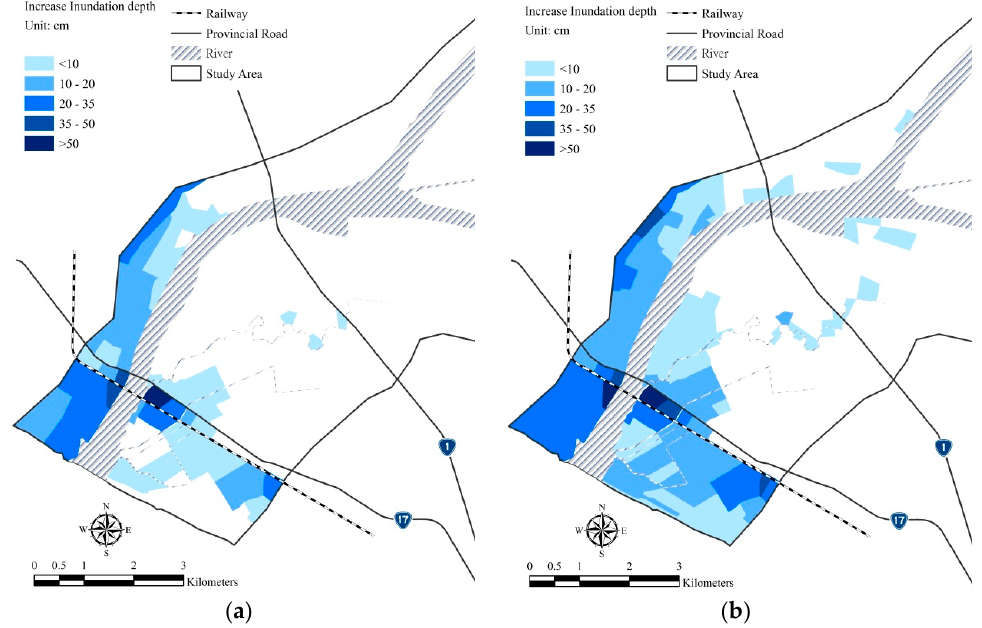
Figure 9. ( a ) Spatial distribution of inundation depth increase after land subsidence for a two-day storm under a 5-year return period; ( b ) Spatial distribution of inundation depth increase after land subsidence combined with climate change for a two-day storm under a 5-year return period.